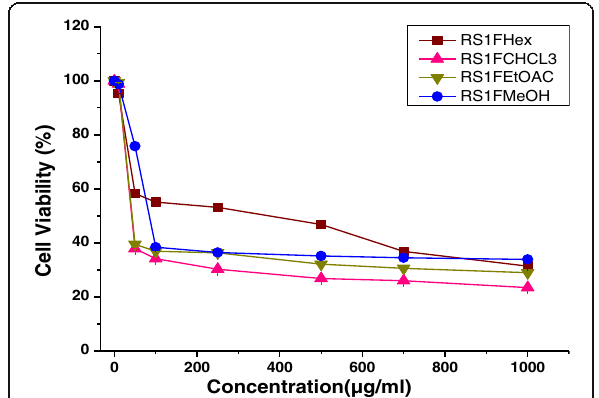
Fig. 5 Growth inhibitory activity of solvent extracts of Rhazya stricta fruits on NT2 cells. The cells were incubated with different concentrations for 48 h, and the cell viability was determined by the MTS assay. The percent inhibition was calculated in comparison to the vehicle control (0.01% MeOH) of two independent experiments. Abbreviations: Hexane extract of Rhazya stricta fruits (RS1F Hex), chloroform extract of Rhazya stricta fruits (RS1F CHCL3), ethyl acetate of Rhazya stricta fruits (RS1F EtOAc), and methanol extract of